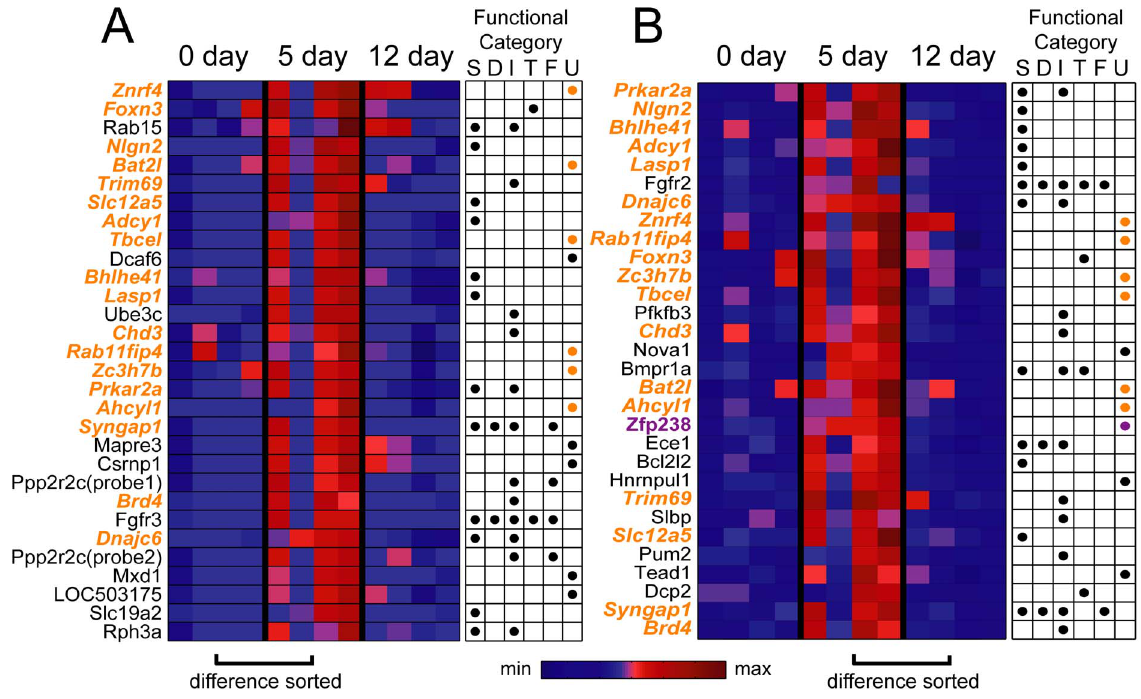
Figure 9. Unclustered genes with the most extreme differential expression as potential new genes related to learning and memory. One way to isolate genes of interest is to select those with the most extreme differences in expression profiles between conditions, assuming that a gene’s functional relevance correlates with its magnitude of differential expression. We present here the sample differential expression data of the 30 genes with the most differences in differential expression between 5 days and 0 day ( A ), and between 5 days and 12 days ( B ), in the form of heat maps. Each row of the heat map shows the data of one gene (gene symbol indicated on the left), and the color of each square in the row denotes the expression value of each sample according to a color map with red showing the highest value, and blue, the lowest. The 0-day columns indicate zero- meaned sample array data (because 0-day is conceptually the Sham of itself) while the 5day and 12day columns indicate the difference between the sample data in the Reach group and the mean value of the Sham group. To the right of the heat map is a table indicating to which functional categories each gene belonged (S, synapse; D, development; I, intracellular signaling; T, transforming growth factor b receptor activity; F, fibroblast growth factor family; U, unclustered). Gene names shown in orange are the ones common to both lists. The several unclustered genes that show up in both lists are marked with orange dots in the table on the right. In B , the gene highlighted in purple ( Zfp238 ) is one whose potential roles in learning and memory are further described in Discussion.